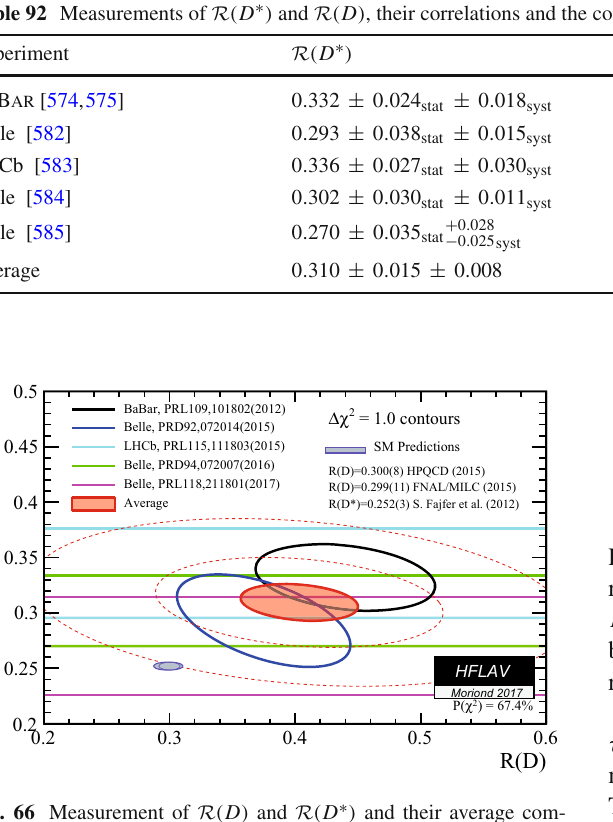
Compared to B + → τν τ , the B → D ( ∗ ) τν τ